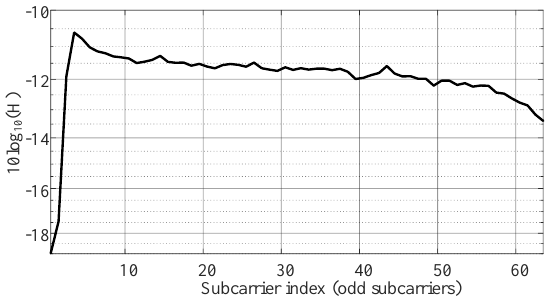
Figure 16. Experiment channel frequency response.